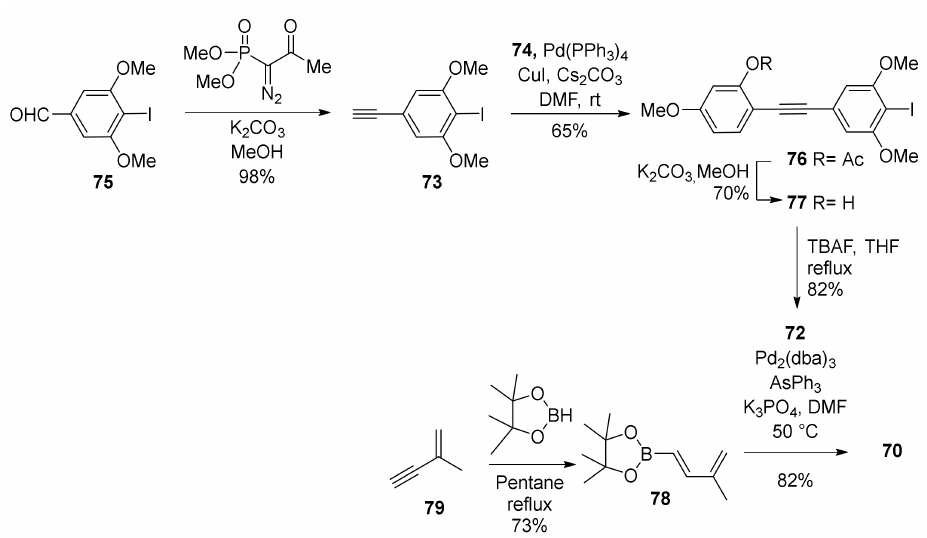
Figure 22. Synthesis of diene 70